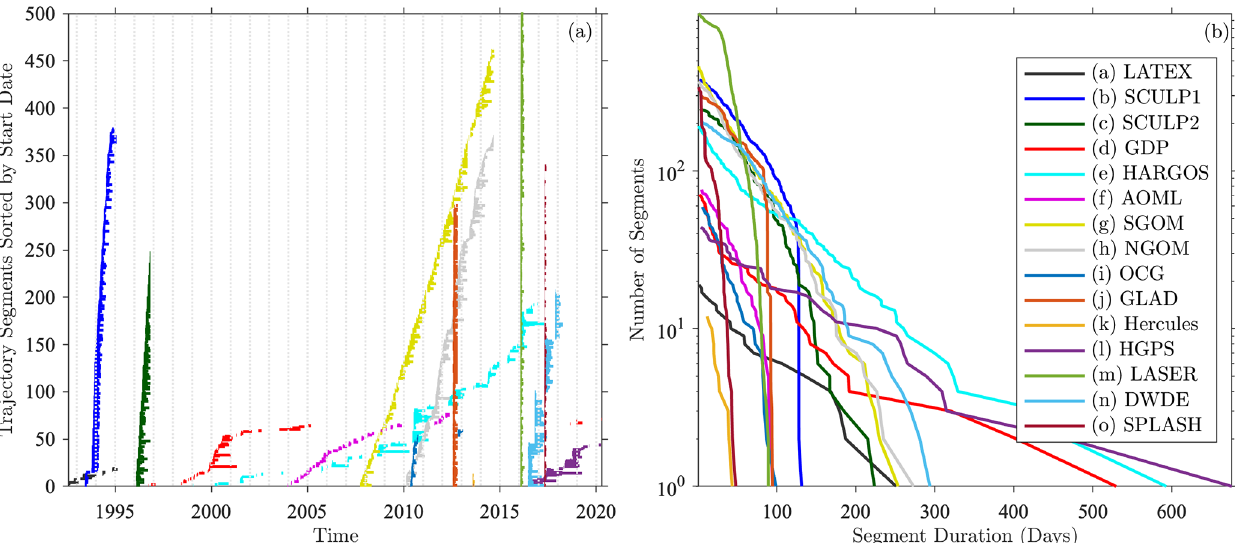
Figure 5. Temporal ranges (a) and duration distributions (b) of drifter trajectory segments from the various sources, after the processing described in Sect. 4.1, with the color key shown in panel (b) . In panel (a) , each small horizontal line marks the temporal range of a different drifter trajectory. The y axis is the trajectory segment number within each data source, sorted in order of the date of the first measurement point. For display purposes, the upper limit of the y axis is set to 500 trajectories, although the LASER experiment has nearly 1000 trajecto- ries. In panel (b) , the lines show the number of trajectories exceeding a specified duration with a logarithmic y axis. The lower limit of the y axis is 1 and gives the duration of the longest trajectory segment in each